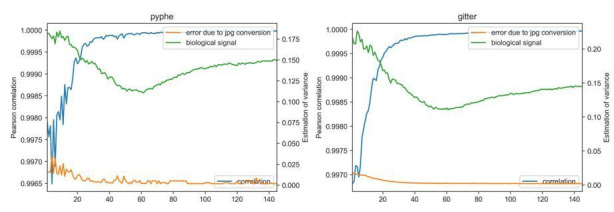
Image conversion to jpg has negligible impact on results.Each image of a growth curve consisting of 145 images (shown on x-axis) was analysed in the original tiff format and in the converted jpg, using gitter (right) and pyphe-quantify in batch mode (left). The correlation (blue line) is extremely high for all images (>0.996) and increases as colonies get larger and darker. The median relative error abs(size(jpg)-size(tiff_image))/size(tiff) is shown (orange) and is practically 0 compared to the biological signal (median absolute deviation of all colony sizes per plate).